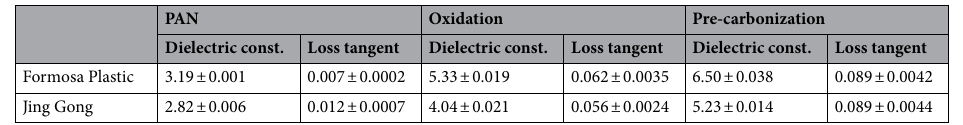
Table 2. The measured dielectric constants and loss tangent for the two brands at 100% volumetric percentage for three stages: PAN, oxidation, and pre-carbonization.